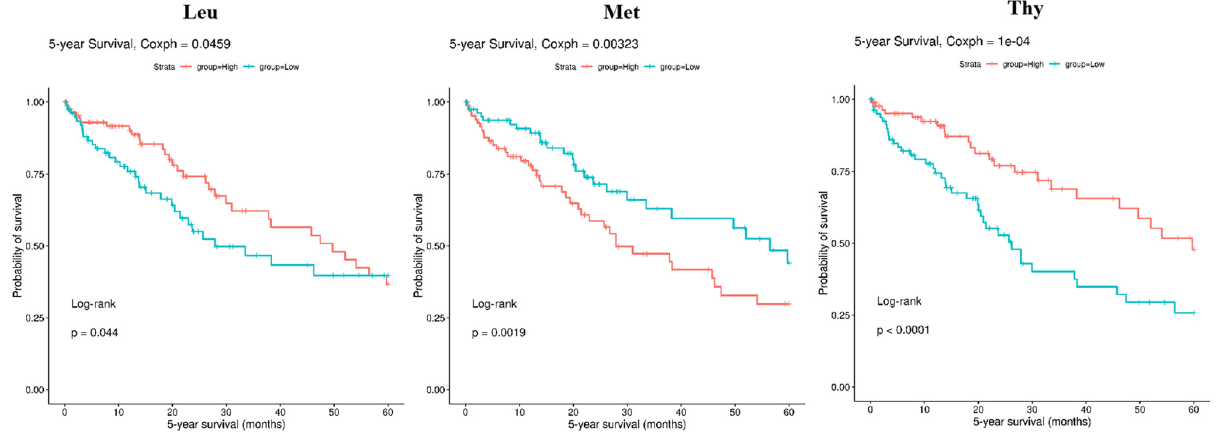
Figure 3: Di ff erentially expressed AAs among di ff erent tumor grades of patients with liver cancer.